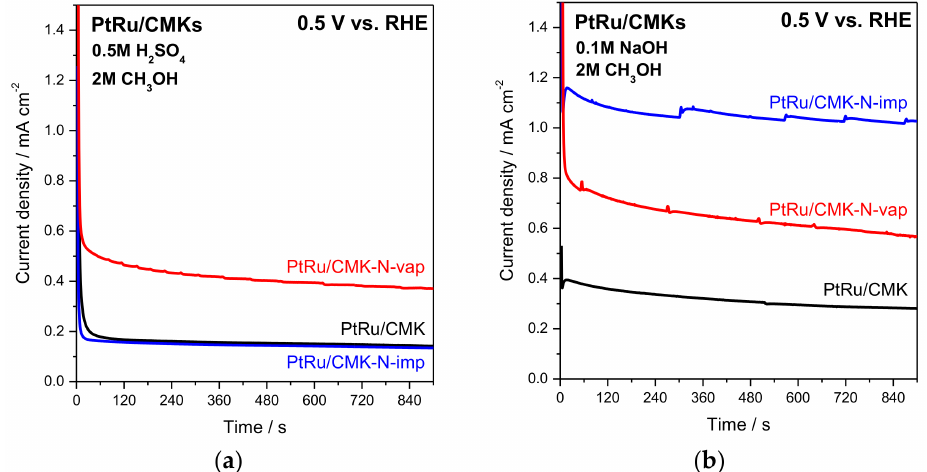
Figure 7. Electrooxidation of methanol by chronoamperometry at 0.5 V vs. RHE for 900 s in deareated 2 M methanol (CH 3 OH) in: ( a ) 0.5 M H 2 SO 4 electrolyte; ( b ) 0.1 M NaOH electrolyte. Room temperature, 50 µ g PtRu cm − 2